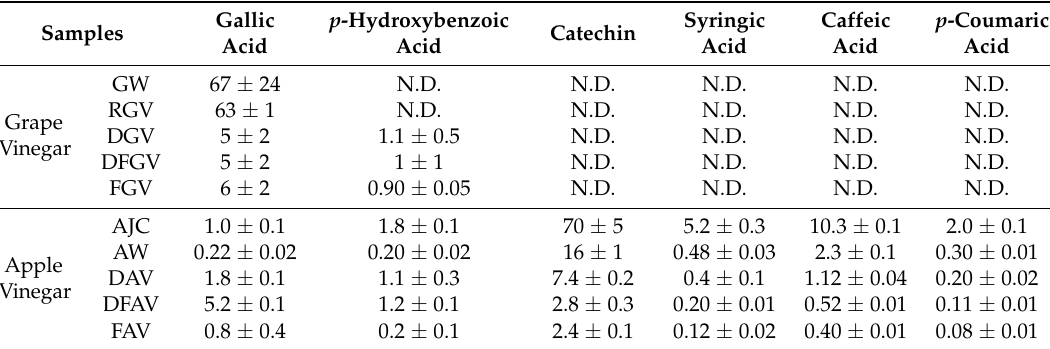
Table 3. Phenolic acid profiles of the grape and apple vinegar processing